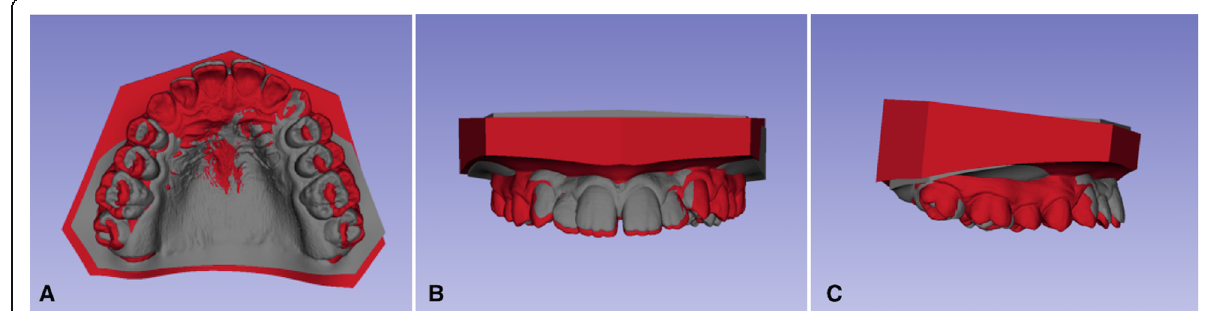
Fig. 3 Superimposition of the pre-treatment (gray) and posttreatment (red) digital models. A Anterior view. B Frontal view. C Lateral